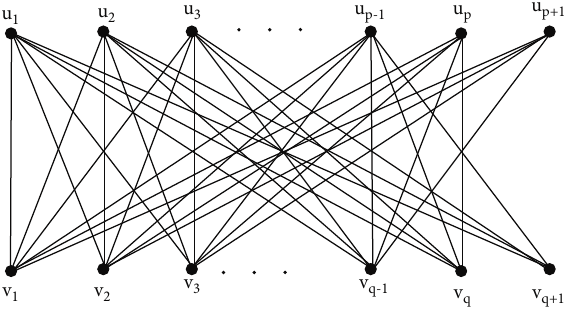
Figure 1: G c � ( T ( p,q )) c graph with m � pq + p + q −